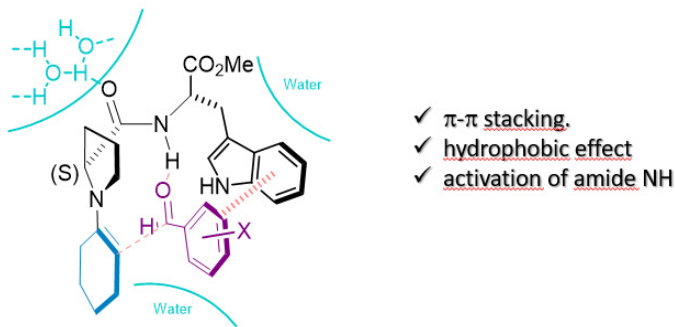
Figure 3. Proposed transition state for the asymmetric aldol reaction between cyclohexanone and p - nitro benzaldehyde catalyzed by dipeptide 4 .